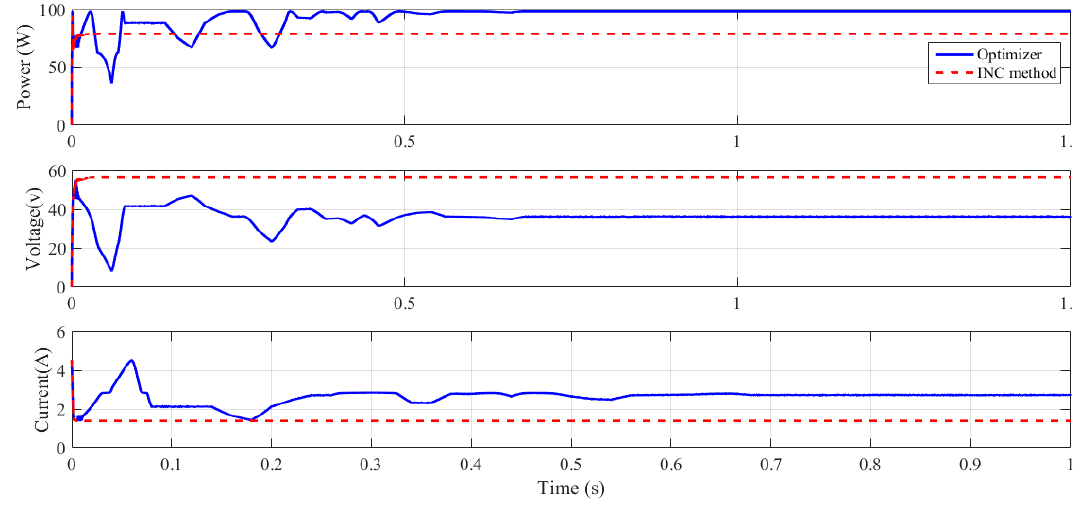
Figure 12. The performance of HPVTEG under PSC.